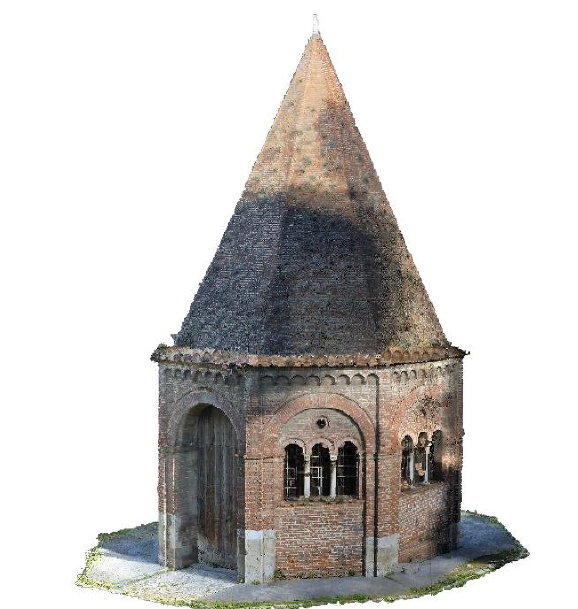
Figure 4. Texturized 3D model.